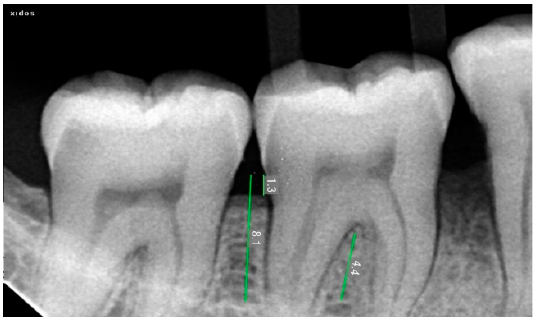
Figure 7. Six Months Post-Operative Radiograph of 46 treated with BM + NB.